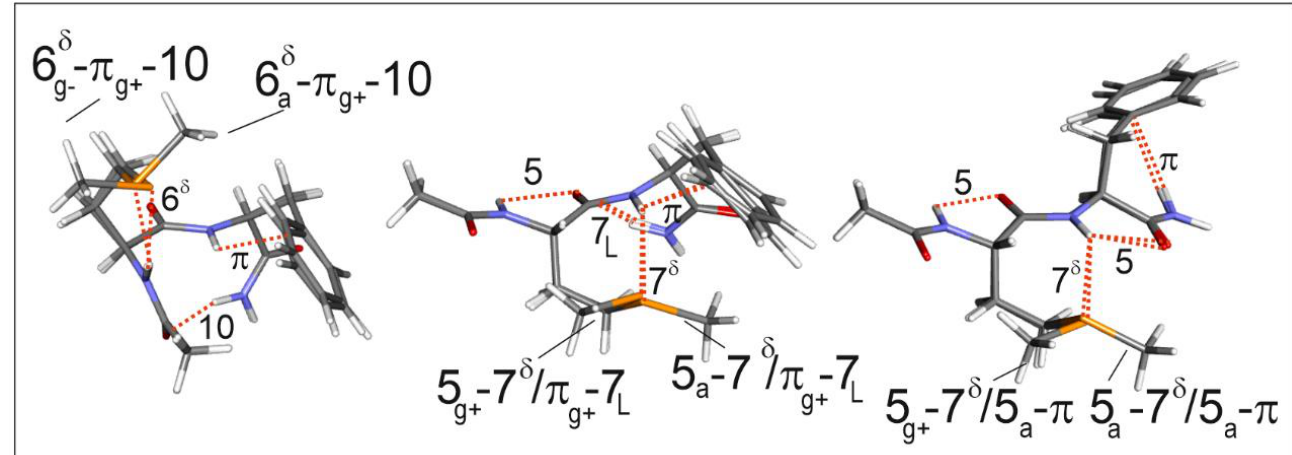
Figure 1. Typical low energy conformations of the folded (left), semi-extended (center) and extended (right) conformational families of Ac-Sem-Phe-NH 2 , as obtained at the RI-B97D3(BJ-abc)/def2-TZVPPD level of theory (see text for terminology details). The folded and semi-extended/extended forms are shown with a gauche + and anti Phe side-chain, respectively (labeled by the second subscript), which corresponds to their most stable conformation. The family of semi-extended forms, illustrated here by the gauche+ orientation, is much richer since alternative backbone and side-chain orientations can also be energetically competitive; also see text for the terminology used. Note here that for each conformation, the Sem side-chain can exhibit two terminal orientations (labeled by the first subscript).